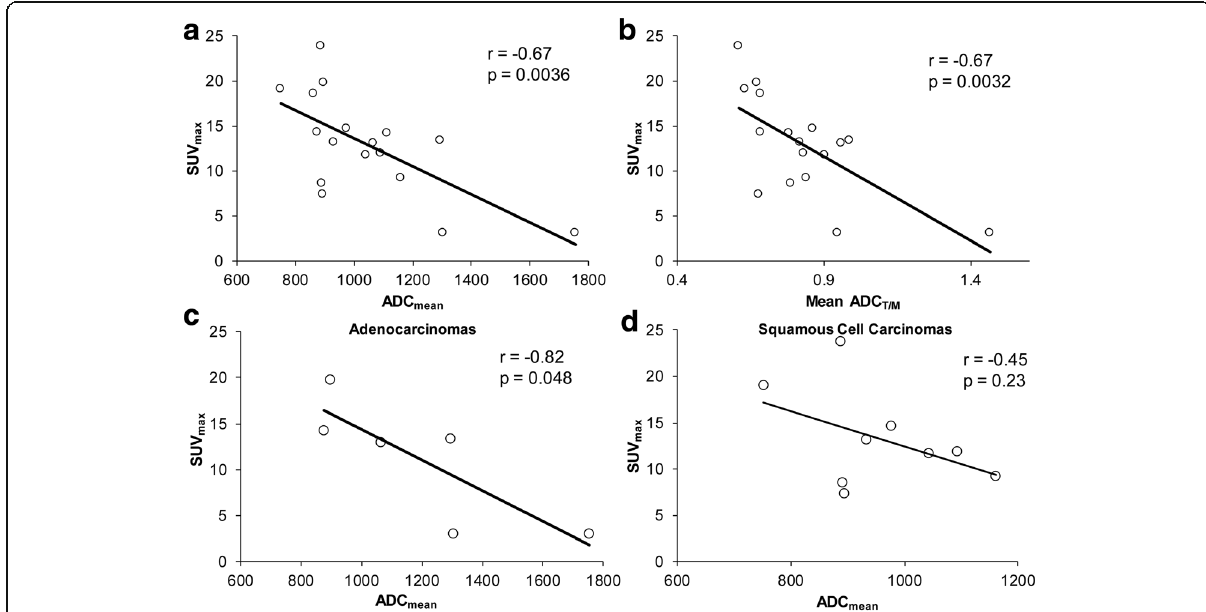
Fig. 1 Comparison of the global tumor metrics of SUV max and ADC mean ( a ) and SUV max and ADC T/M ( b ) for all tumors. When SCCAs and AdenoCAs are considered separately, there is still a significant inverse correlation between SUV max and ADC mean for AdenoCAs ( c ), and though there is an inverse correlation in SCCAs, it does not meet significance ( d )